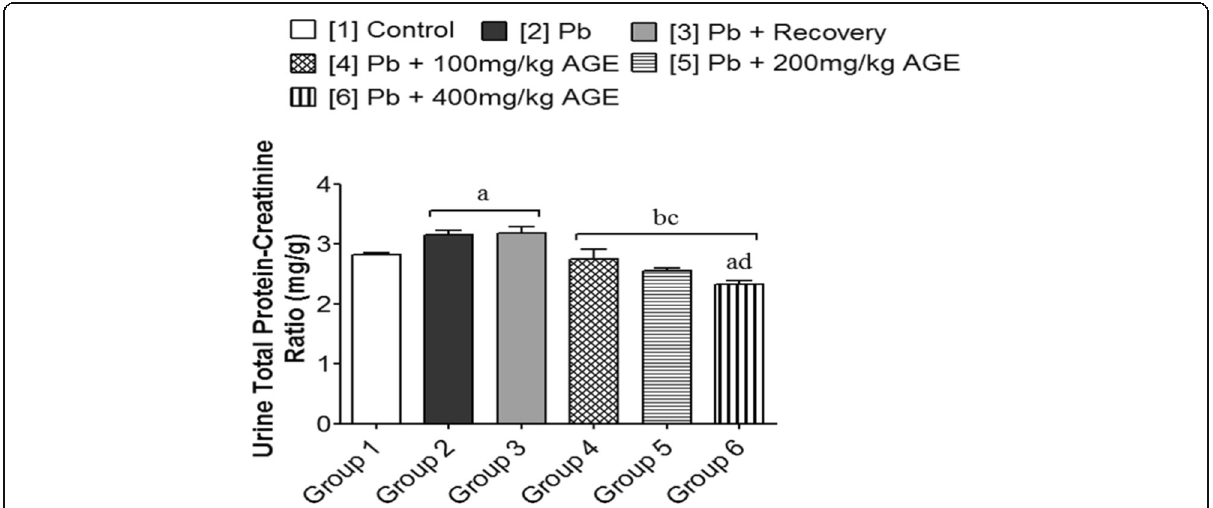
Fig. 3 Effects of AGE on urine total protein – creatinine ratio of Wistar rats with Pb-induced kidney injury. Each bar represents mean ± Standard Error of Mean (S.E.M.) at p < 0.05. a = significantly different from control group [1], b = significantly different from Pb group [2], c = significantly different from Pb + recovery group [3], and d = significantly different from Pb + 100 mg/kg group [4]